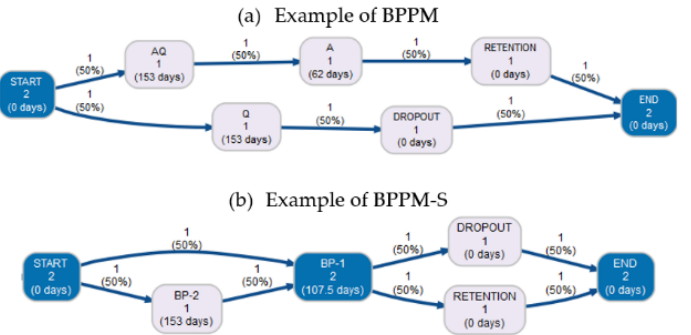
Figure 1. Example of educational trajectories, according to the BPPM and BPPM-S models. ( a ) Shows an example of BPPM. ( b ) Shows an example of BPPM-S. The darker color of the nodes represents a higher percentage of students who went through each state. The thickness of the arrows represents the percentage of students who had transitions between both states. All values are percentages in relation to the total number of students included in each model.